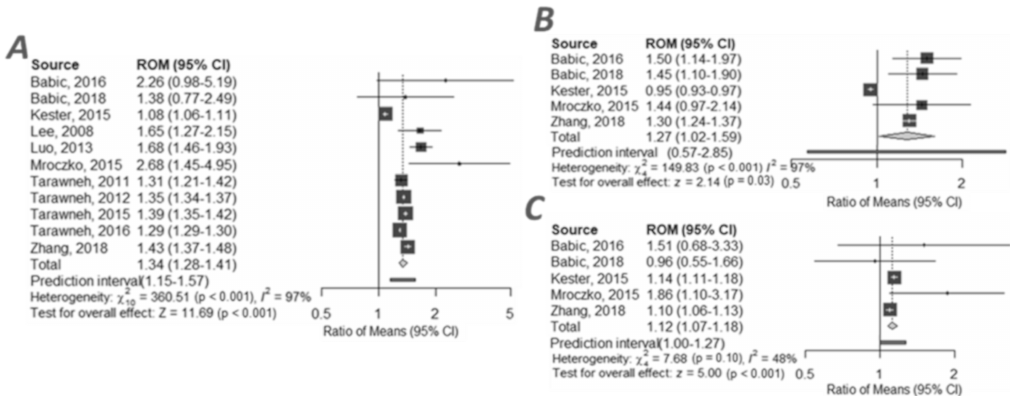
Figure 3. Forest plots of cerebrospinal fluid visinin-like protein 1 ratio in compared groups: ( A ) AD vs. CTRL [20,33–42]; ( B ) AD vs. MCI [33,35,40–42], ( C ) MCI vs. CTRL [33,35,40–42]. Individiual studies and their corresponding 95% Confidence Intervals (CIs) are indicated by filled squares. All average ratios and their corresponiding 95% Cls are indicated by grey